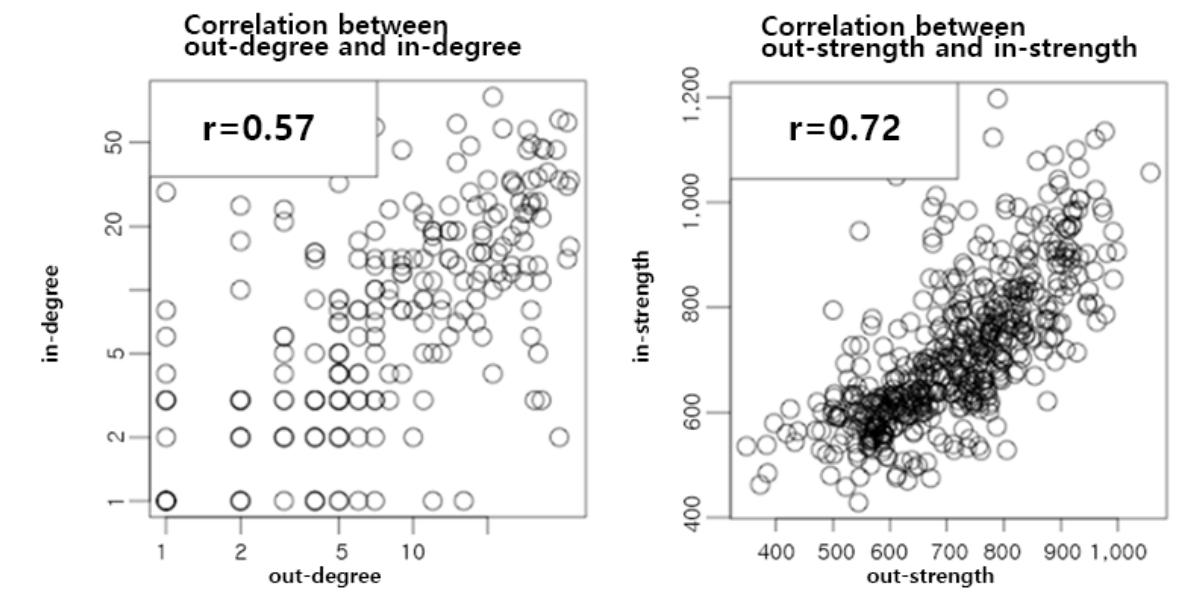
Figure 4. Correlations between in- and out-degrees and in- and out-strengths.